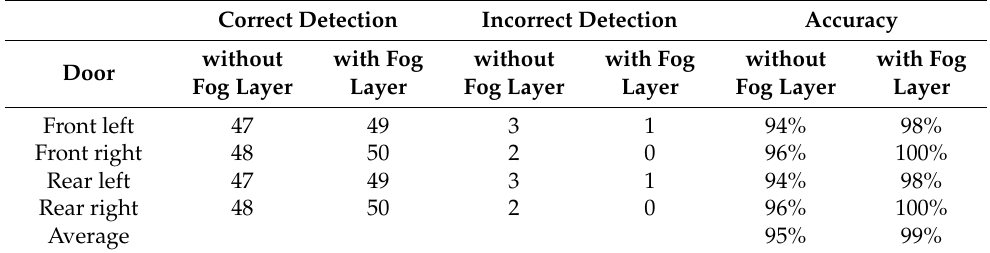
Table 6. The accuracy of seatbelt detection with and without the fog layer. Correct